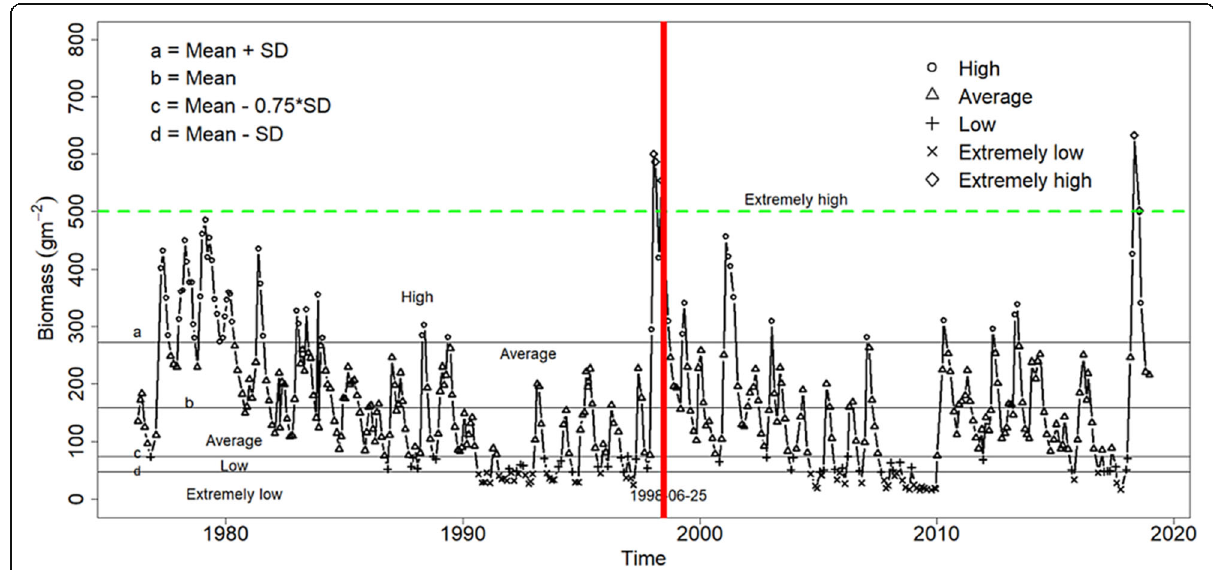
Fig. 8 Pasture biomass averaged for 20 permanent plots measured across the major habitats of Amboseli